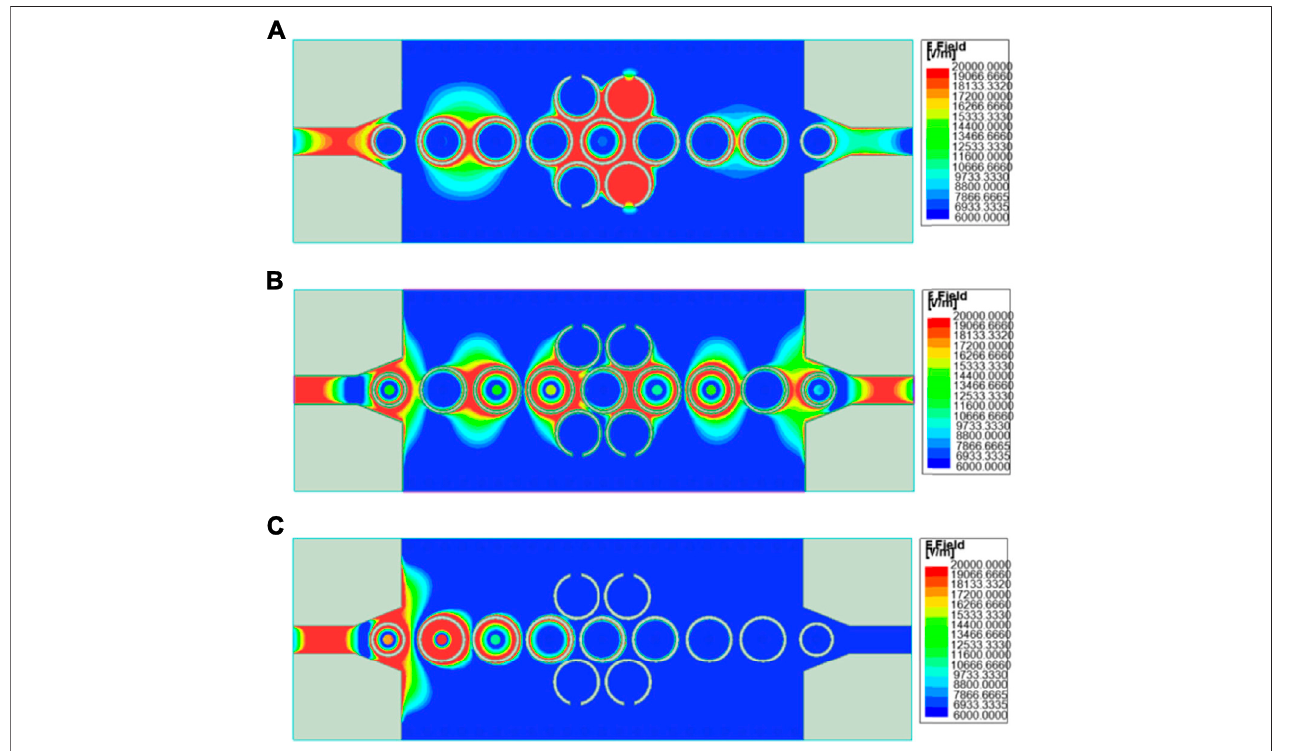
FIGURE 4 | Simulated electric fi eld distributions of the BPF based on the proposed SSPP at (A) 16.8 GHz, (B) 22 GHz, and (C) 26 GHz.